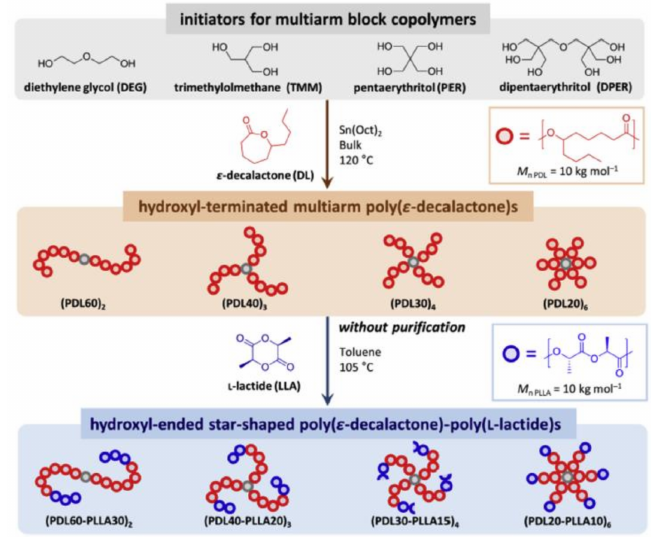
Figure 6. Multiarm block copolymer of ε -decalactone and lactide (from [48] with the permission of Polymer